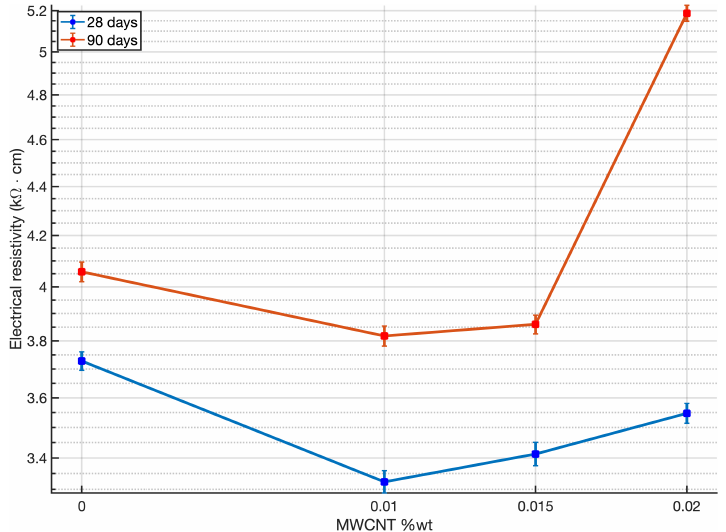
Figure 5. Average electrical surface resistivity of MWCNTs-mortar